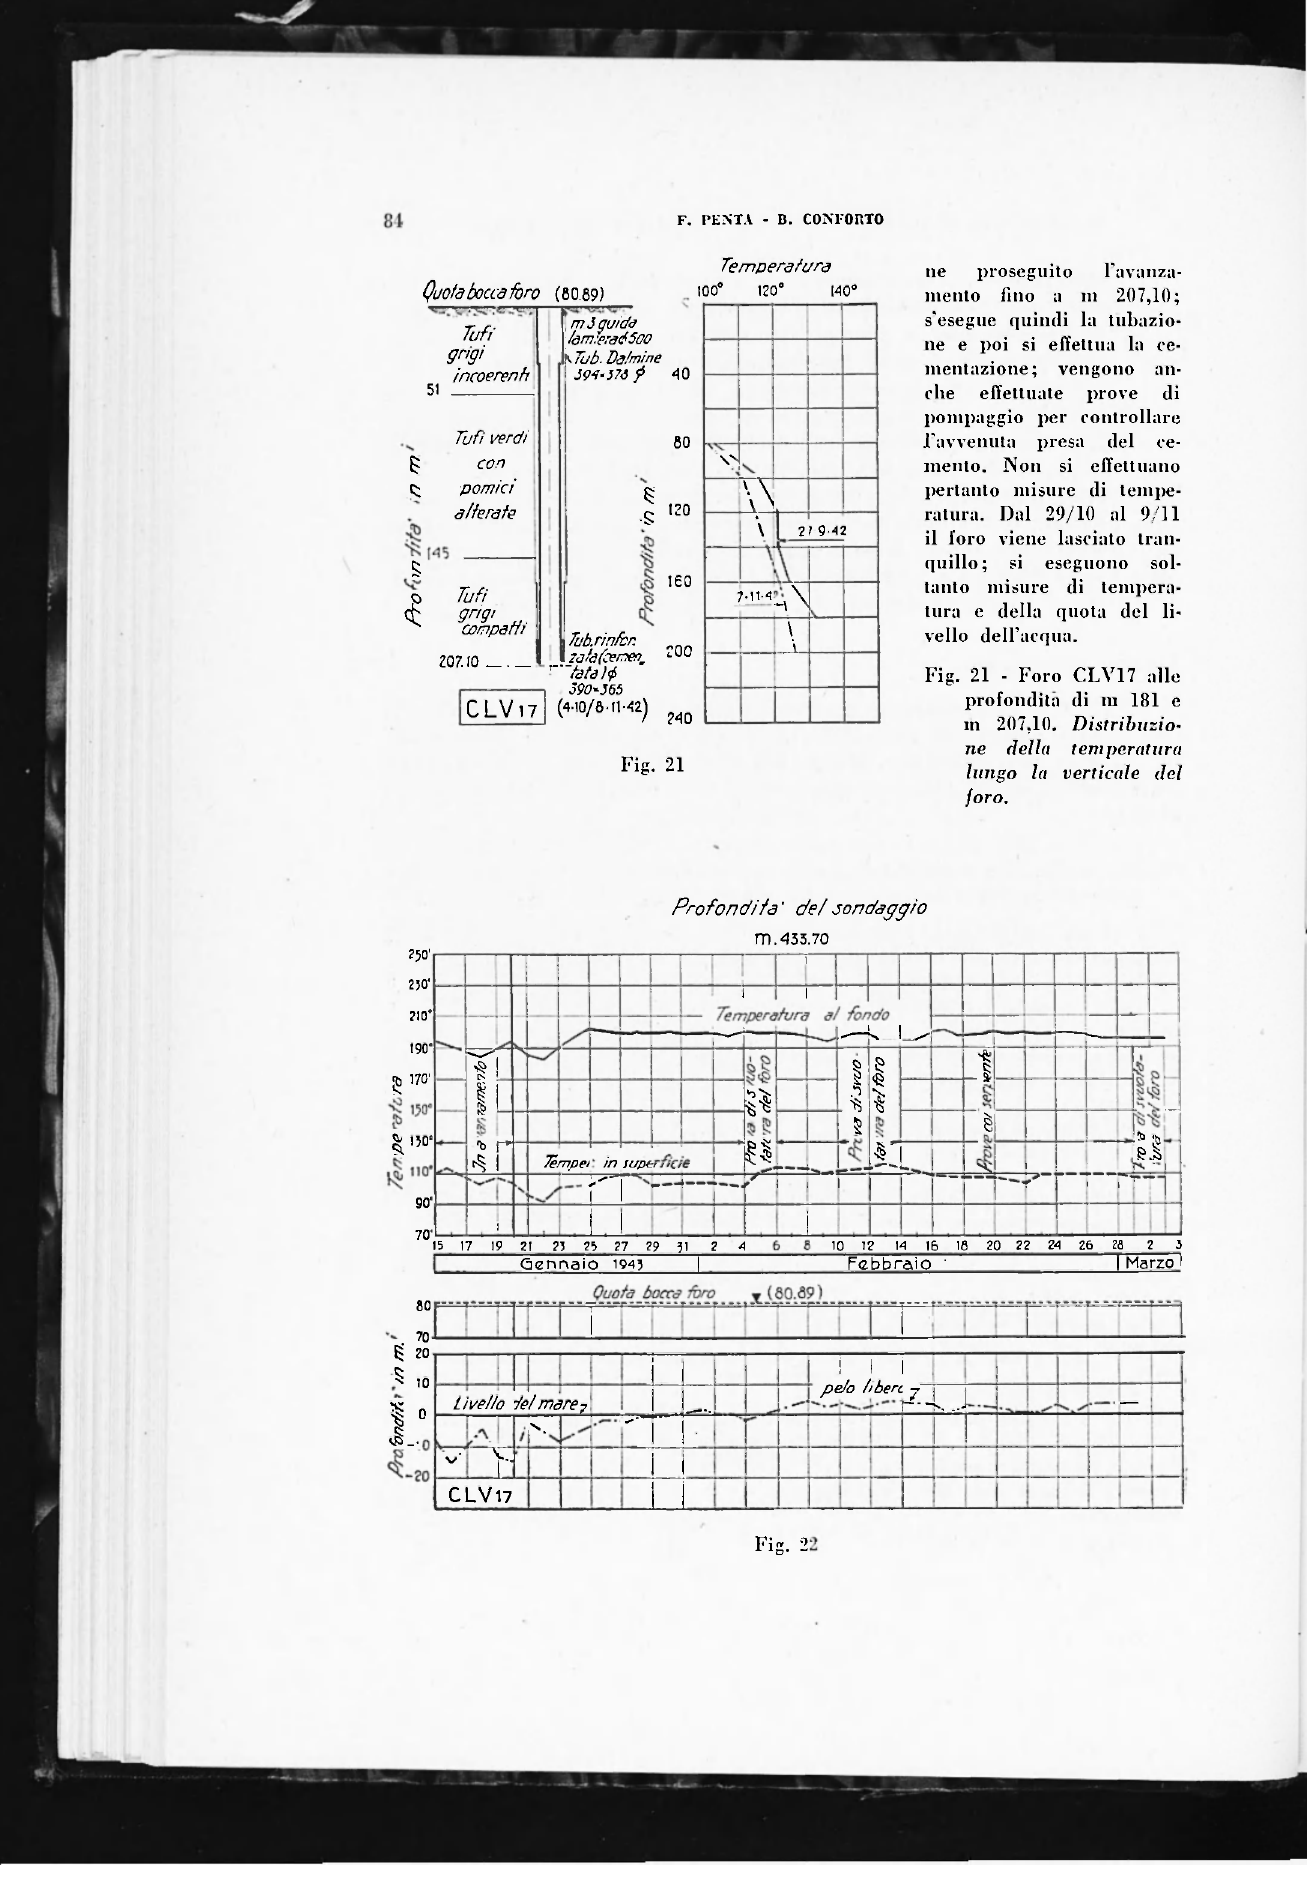
Fig. 21 - Foro CLV17 ap- profondita di ni 181 e in